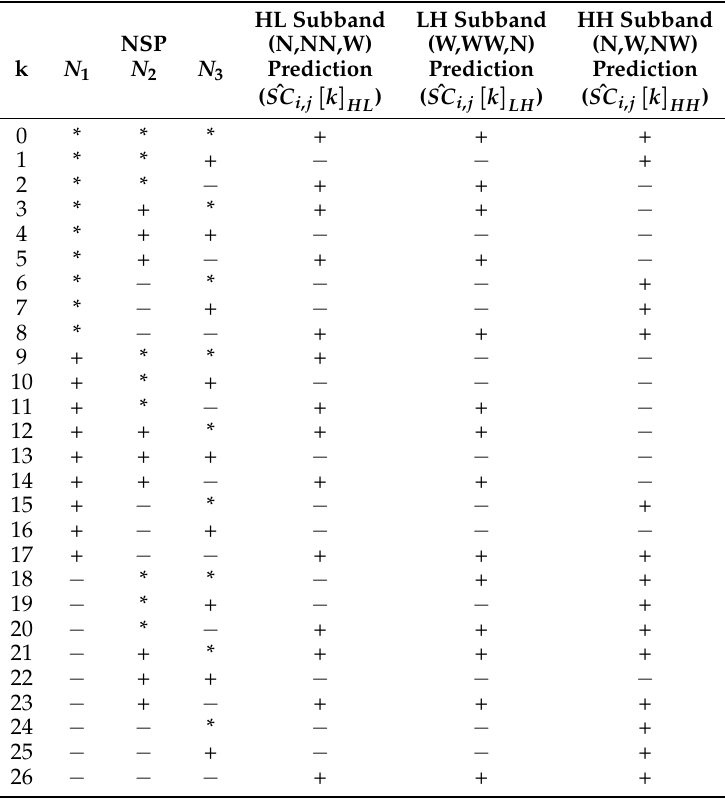
Table 3. Sign-prediction table of Barbara image for HL, LH and HH subbands. For each subband type, N 1 , N 2 and N 3 are the corresponding neighbor’s sign